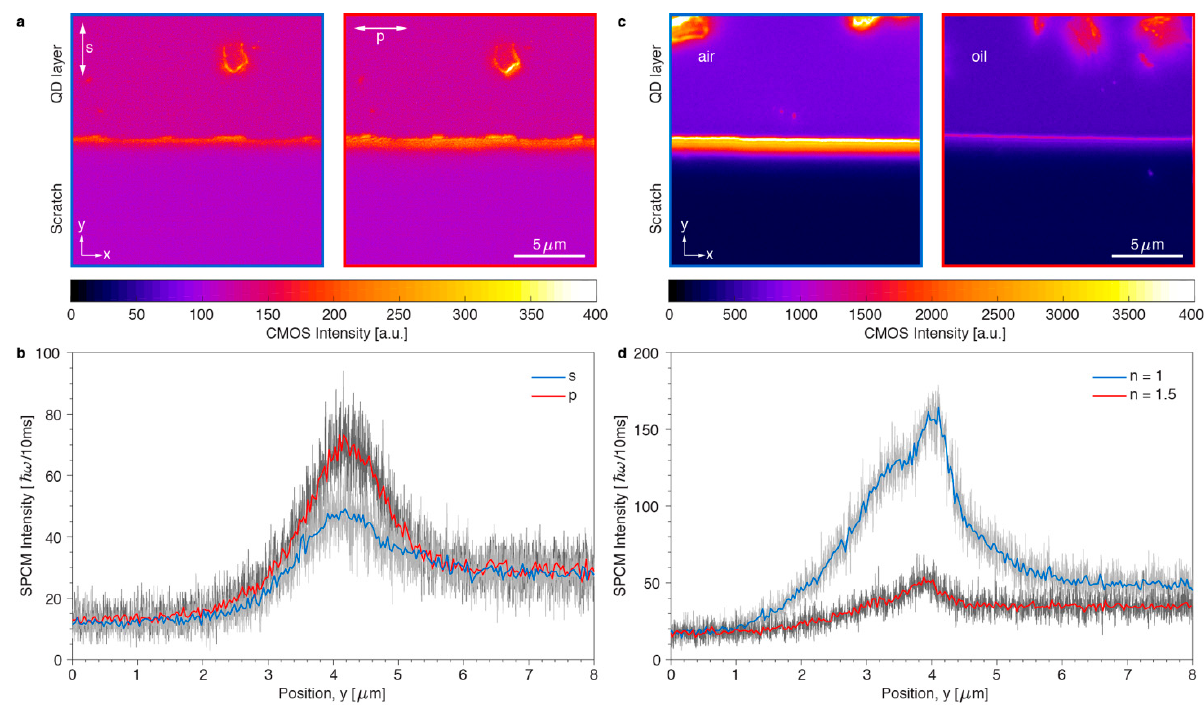
Figure 8. Experimental characterization of the emission waveguided within the thick film of SNPs ( N = 11). ( a ) Fluorescent images of the sample with polarizer oriented perpendicular (left) and parallel (right) to the edge of the film. ( b ) Integrated single-photon intensity as a function of position for s- and p-polarized emission from the layer. ( c ) Fluorescence images of the edge of the film covered with air n = 1 (left) or covered with oil n = 1.5 (right). ( d ) Single-photon intensity profiles scanned over the edge of the film covered with air or oil.